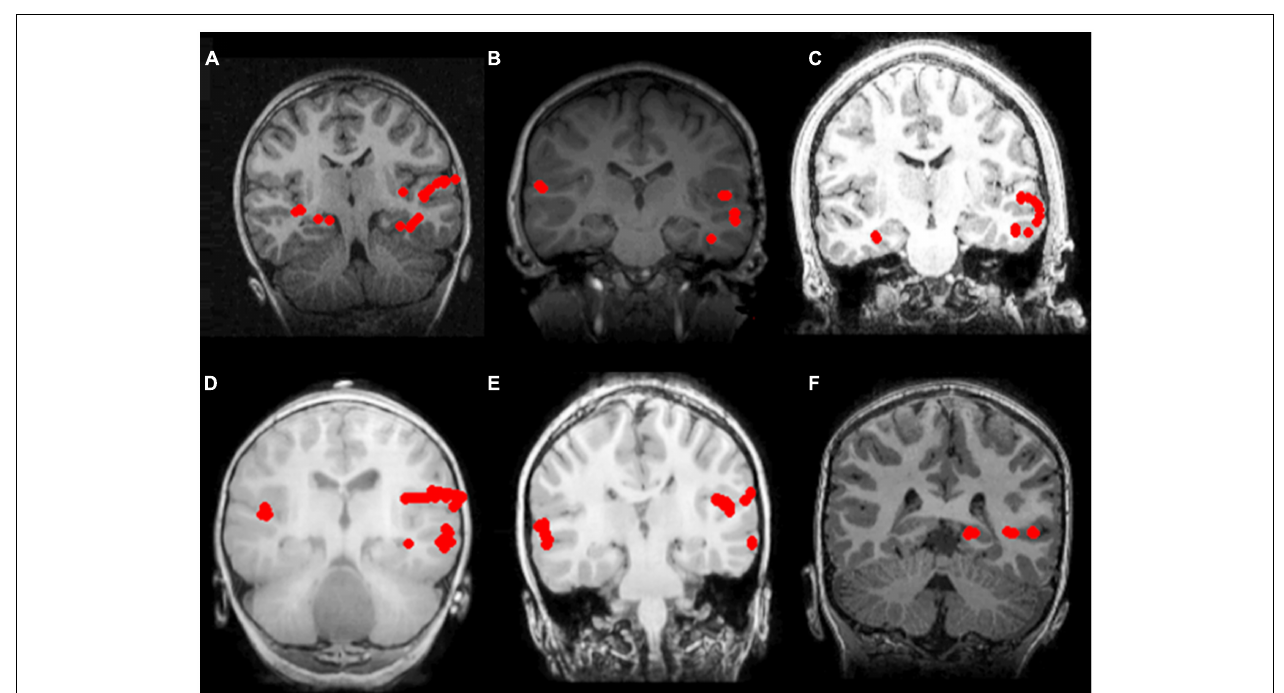
female with ganglioglioma of the left temporal lobe; (C) 16 year-old male with symptomatic partial seizures of right temporal lobe origin; (D) 2 year-old male with cervical medullary tumor; (E) 6 year-old male with symptomatic epileptic spasms of right hemisphere origin; (F) 6 year-old male with symptomatic partial seizures of left temporal lobe